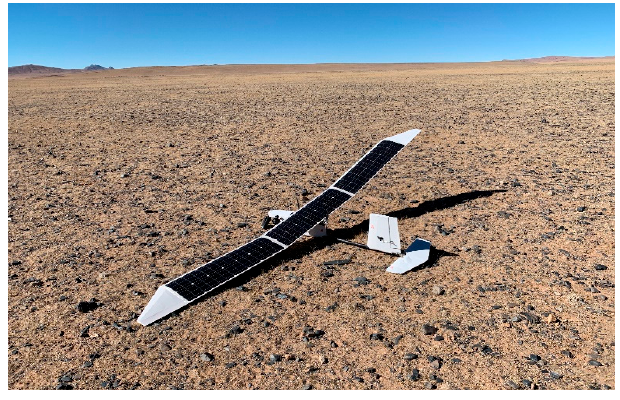
Figure 1. Small hand ‐ launched solar ‐ powered UAV (unmanned aerial vehicle).